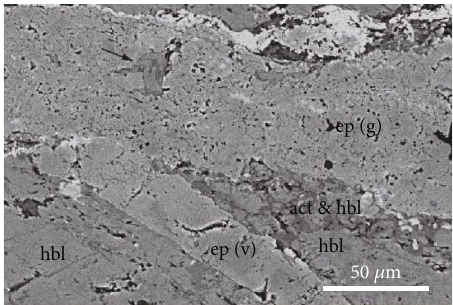
Figure 5: Backscattered electron image of epidote vein (ep(v)) cut by granular epidote cataclasite seam (ep(g)). Large amphibole (hbl) in host gneiss cut by hornblende- (hbl-) actinolite (act) cataclasite, relict clasts (arrowed) of which appear within the granular epidote